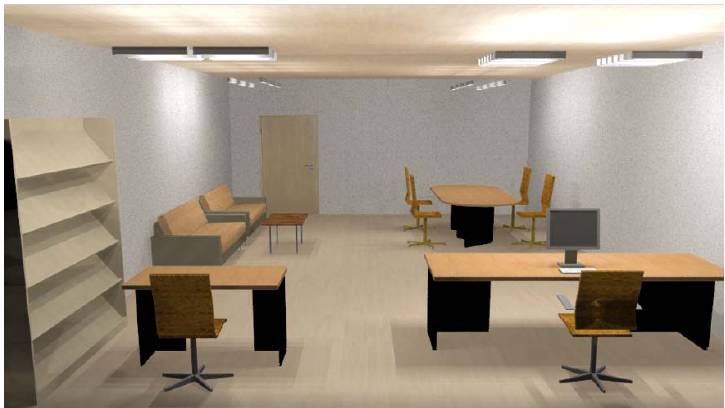
Figure 5. Workplane overlap from Illumination